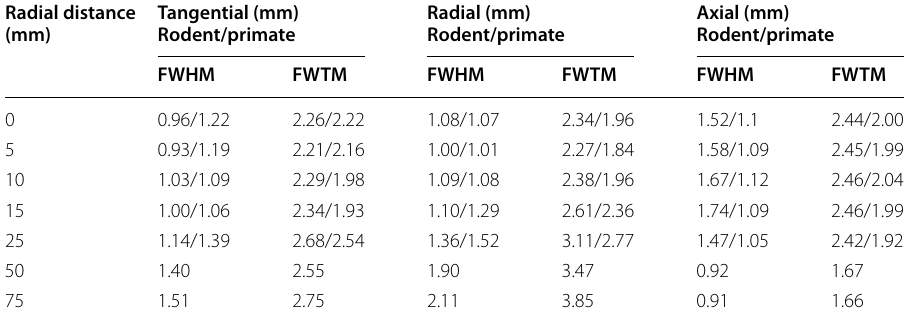
Slice thickness (mm):